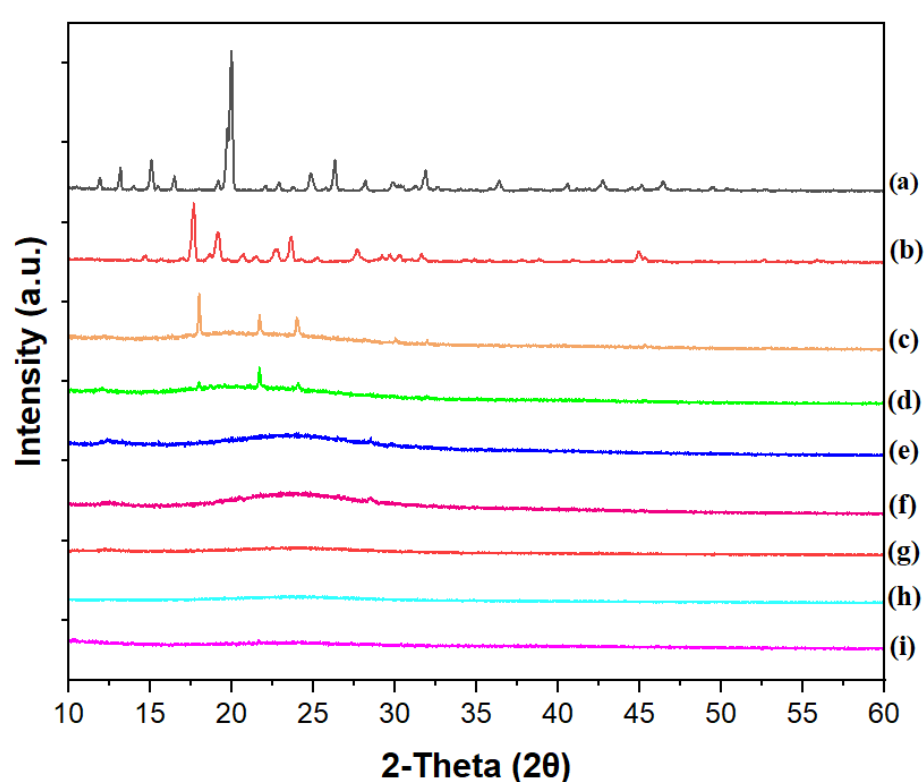
Figure 11. XRD diffractograms of haloperidol (a), haloperidol HCl (b), CHI/P3HPEI films loaded with haloperidol at various% drug loading, 5.0% (c), 2.5% (d), 2.0% (e), 1.75% (f), 1.5% (g), and 1.25% HP films (h) and drug-free CHI/P3HPEI film (i).